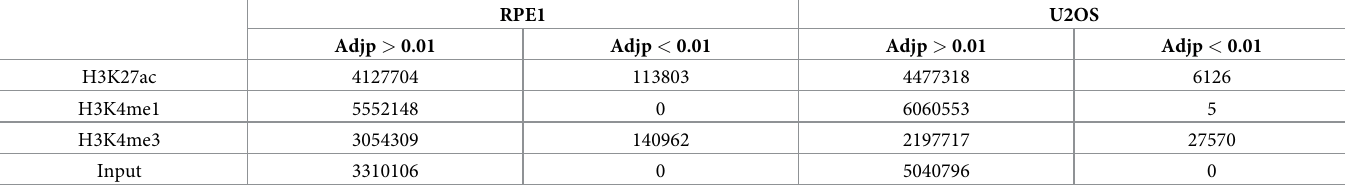
Table 11. The performances achieved by csaw applied to the present data set. Adjp: adjusted P -values computed by